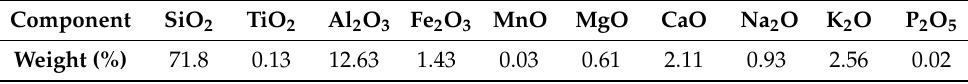
Table 1. Chemical composition of natural